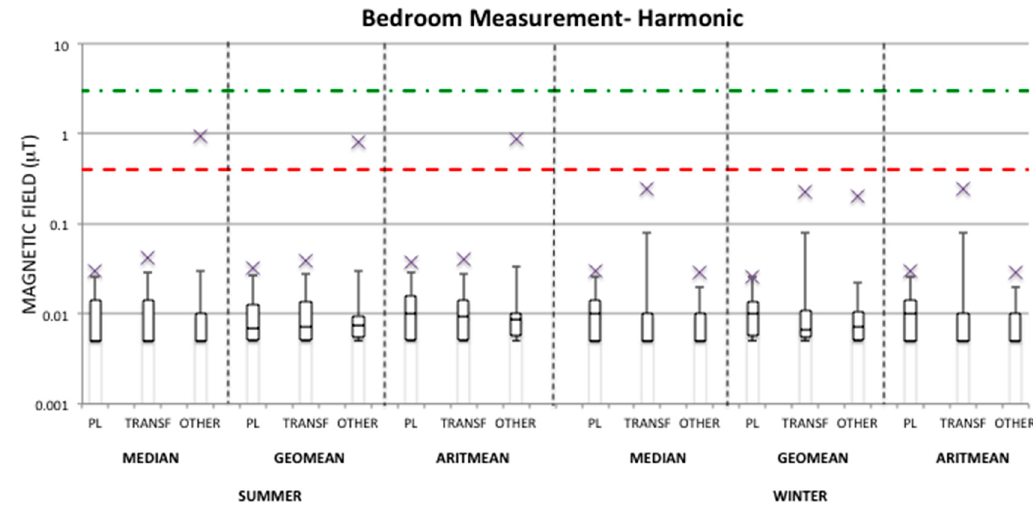
Figure 3. Distribution of the median, geometric mean, and arithmetic mean of magnetic field ( μ T) in the harmonic frequency range (100–800 Hz) indicated as box-plots for personal measurements in both summer and winter periods and in each group (PL, TRANSF, OTHER). The distribution values are indicated in Appendix Table A3.